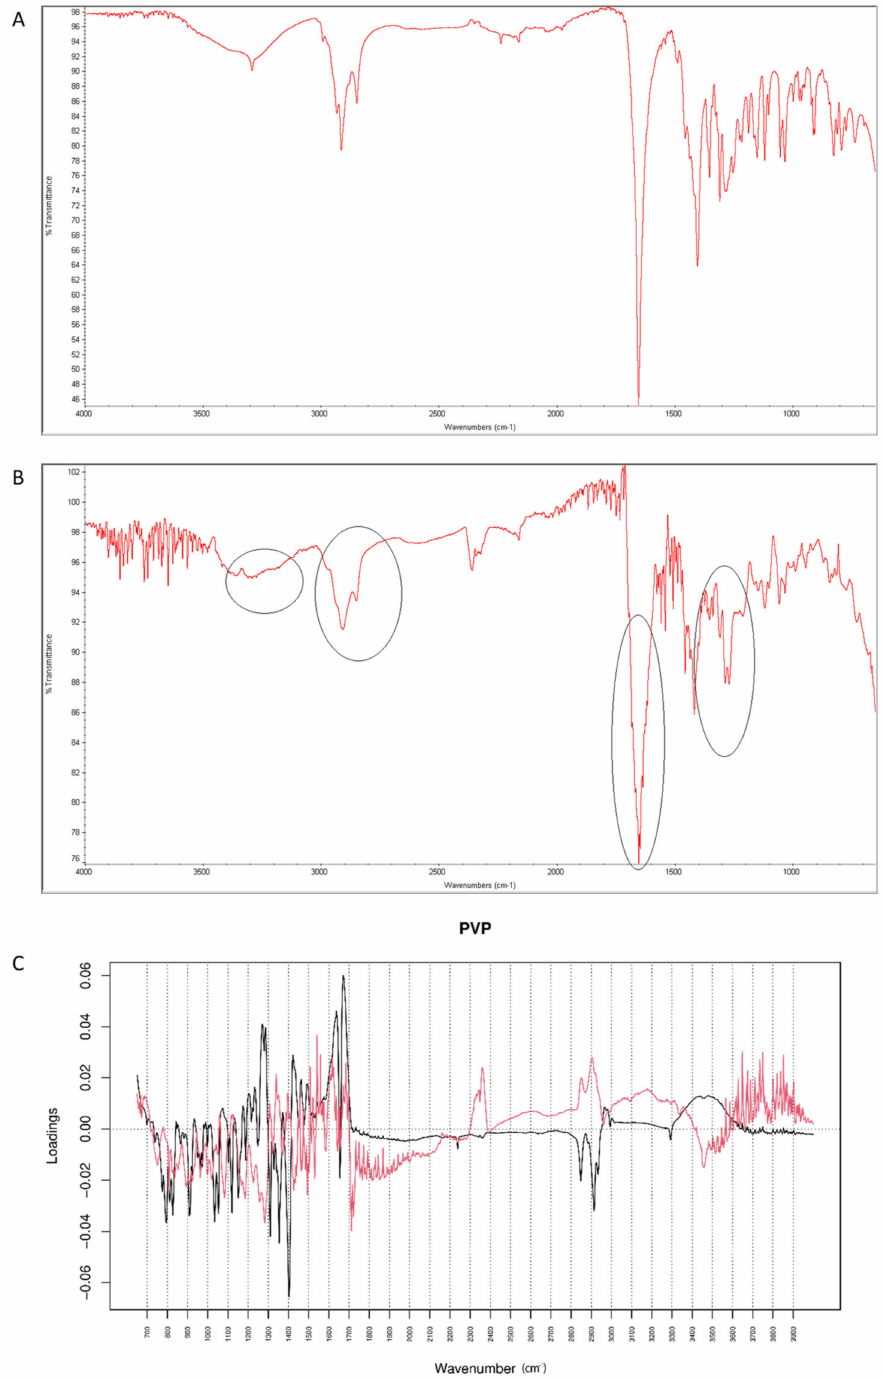
Figure 18. ( A – C ) Vildagliptin and polyvinylpirrolidone (PVP): mid-IR spectra of no stressed mixture ( A ), stressed mixture ( B ) and PCA loadings of the spectra ( C ); PC1 loadings are marked black while PC2 loadings are marked red; most visible differences in the spectrum of the stressed mixture are indicated with